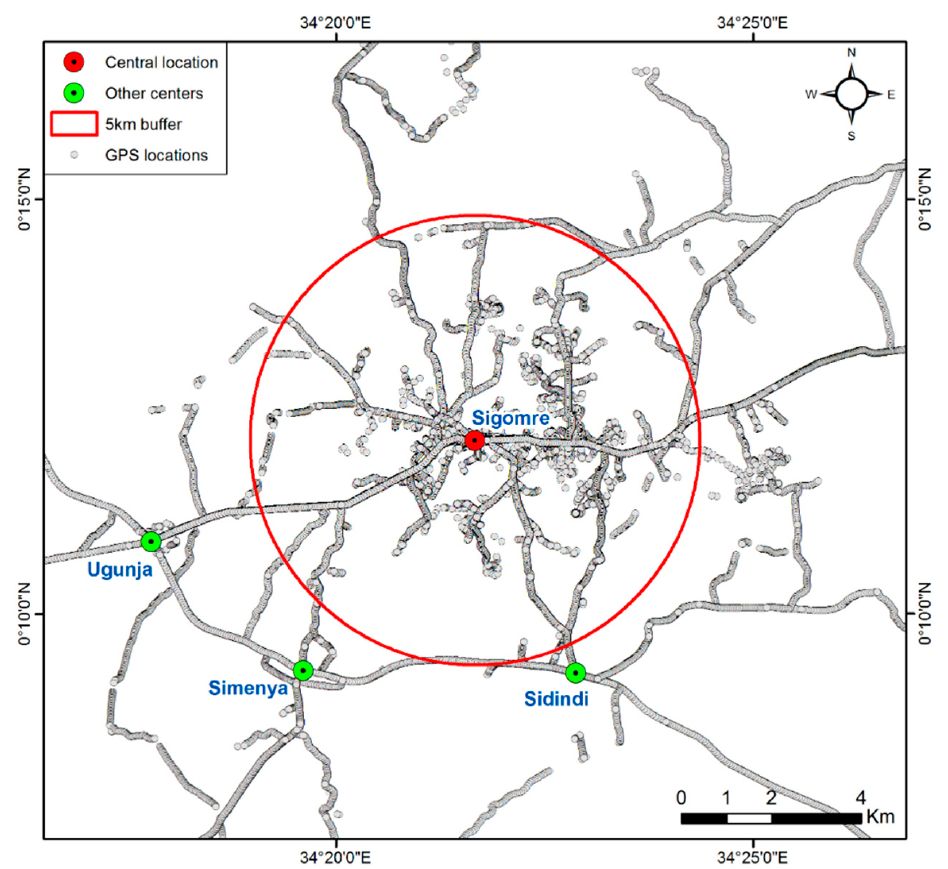
Figure 4. GPS traces of motorcycle taxis in Sigomre area showing a higher concentration of the points closer to the market center and in the surrounding villages.